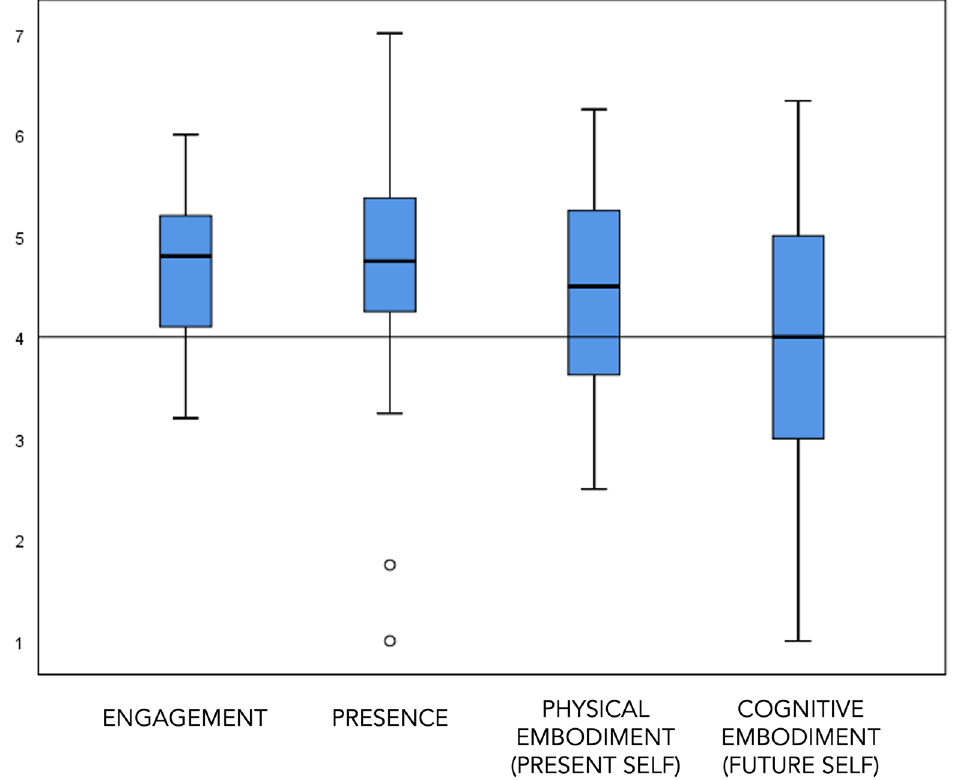
Figure 1. Box plots of questionnaire scores on the four VR experience measures (engagement, presence, physical embodiment of the present self, and cognitive embodiment of the future self). The value of 4 represents the mid-point of the scale (e.g., neither agree, nor